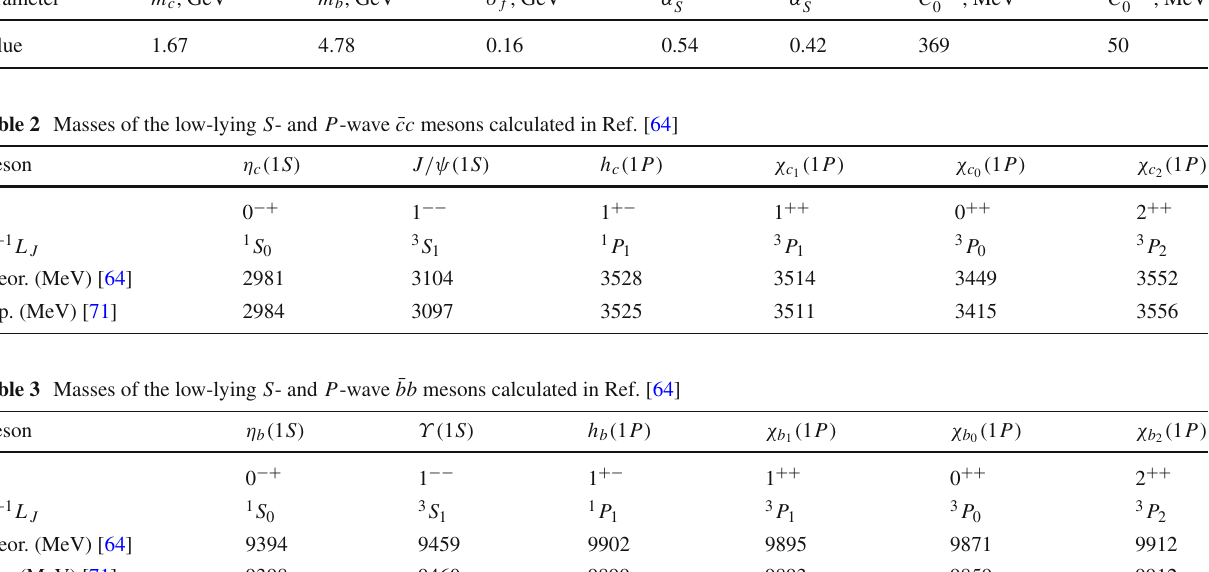
Table 1 Parameters of the model fixed from the fits to the spectrum of ordinary charmonium and bottomonium in Ref. [64] Parameter